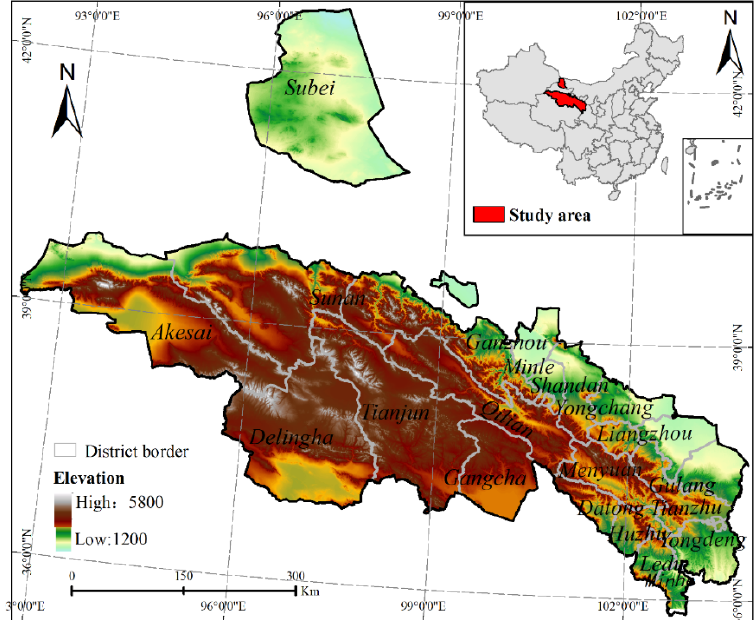
Figure 1. Geographic location of the Qilian Mountains in